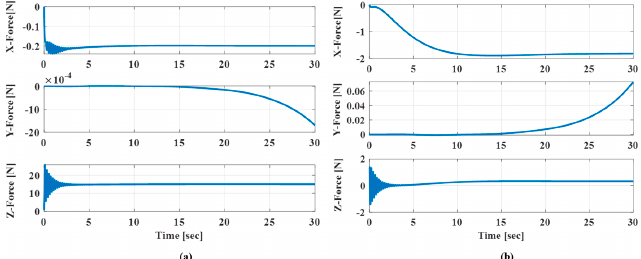
Figure 21. Forces generated by the underwater cable: ( a ) Forces acting on the USV; ( b ) Forces acting on the UUV.